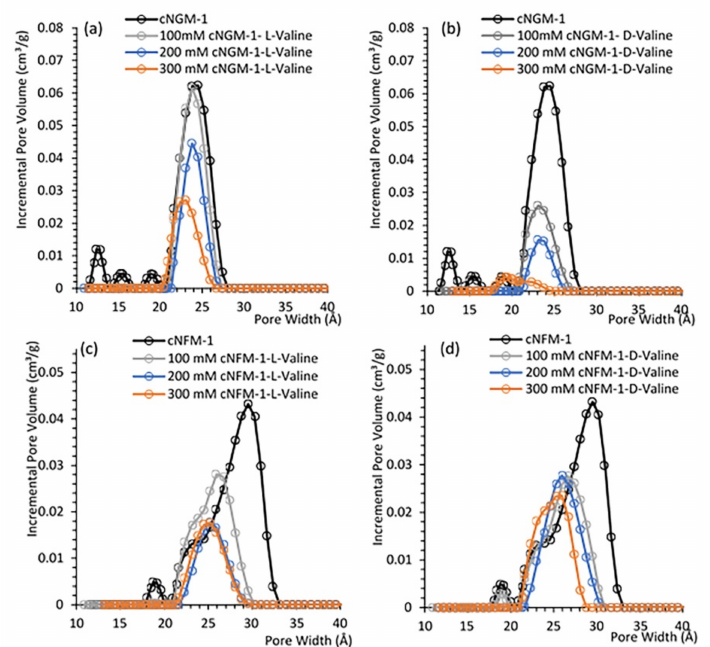
Figure 3. Mesopore size distribution of filtered and dried sample of: c NGM-1 after adsorption of ( a ) L -valine and ( b ) D -valine at concentration of 100, 200, and 300 mM; and c NFM-1 samples after adsorption of ( c ) L -valine and ( d ) D -valine at similar